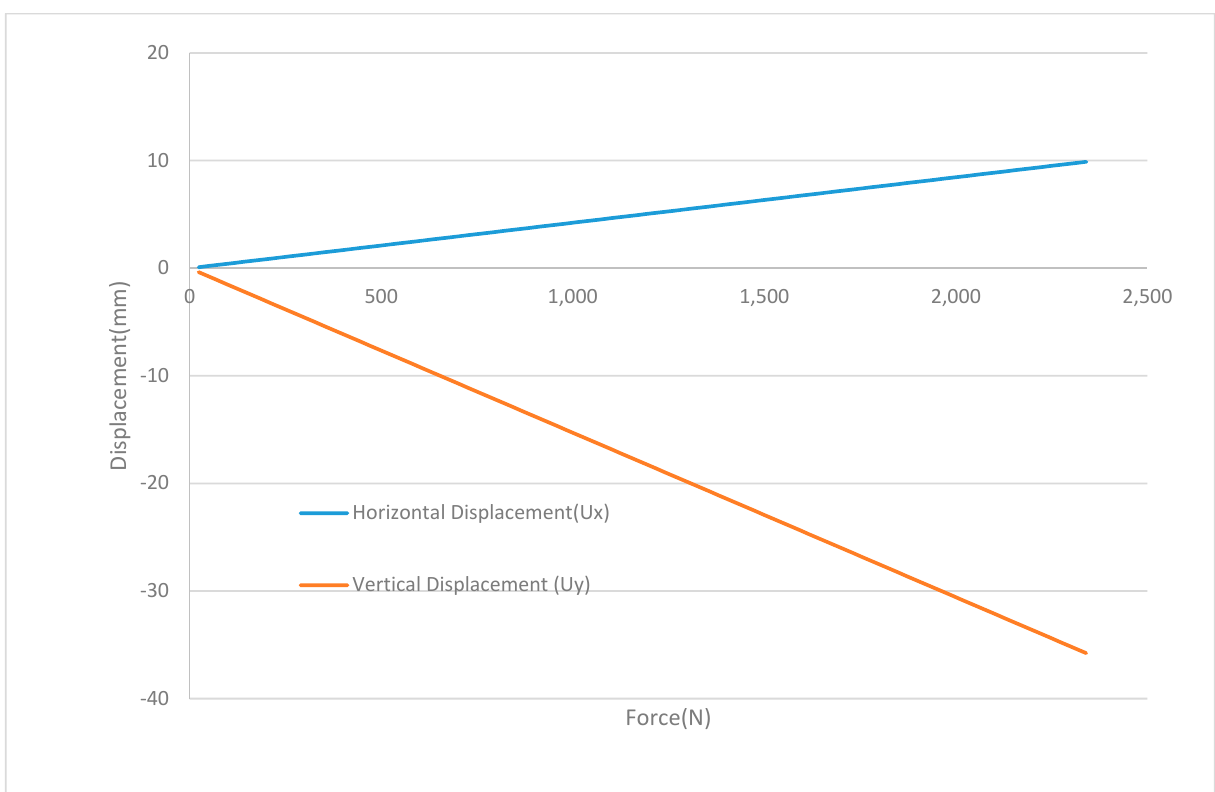
Figure 20. Horizontal and vertical displacements at node 20, element 1126 with coordinate details: ( x = 0, y = 0.25, z = − 4) and 20% FA.